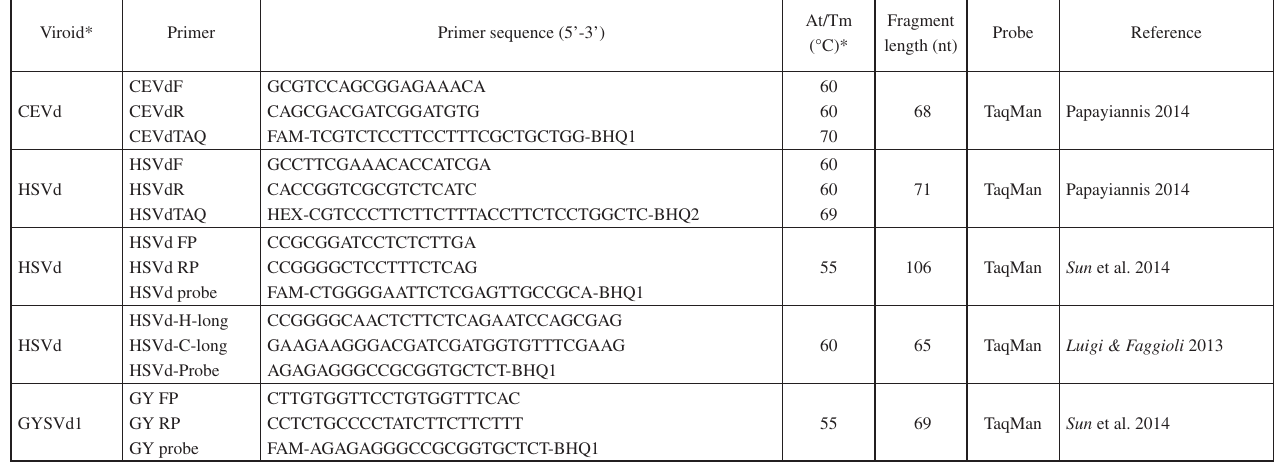
Table 1. Viroid specific primers